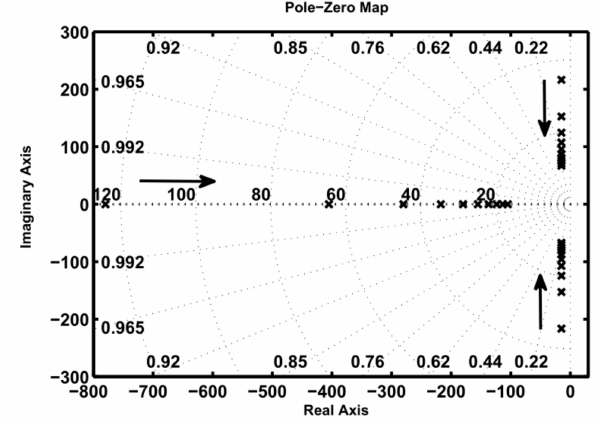
Figure 7. The pole-zero map of proposed control system.